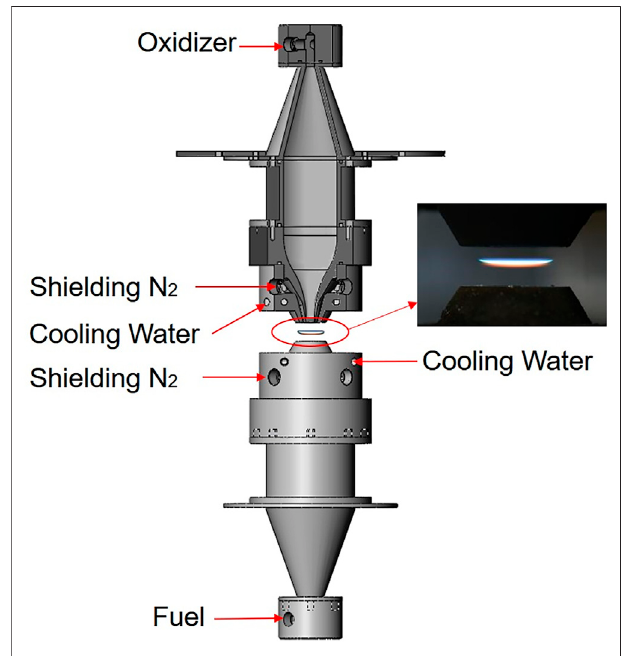
FIGURE 1 | Schematic of the counter fl ow diffusion fl ame (CDF)